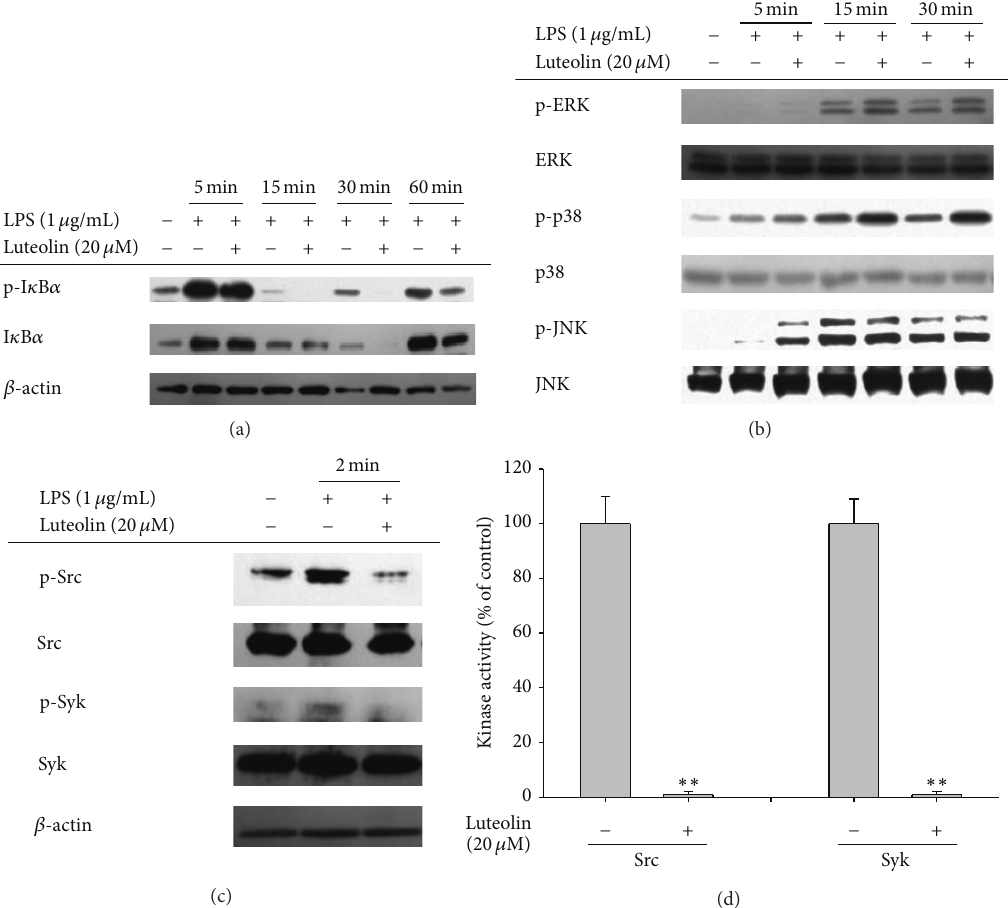
Figure 3: The effects of luteolin on the pathway upstream of NF- 𝜅 B activation. ((a), (b), and (c)) RAW264.7 cells (5 × 10 6 cells/mL) were incubated with LPS (1 𝜇 g/mL) in the presence or absence of luteolin for the indicated times. After preparing whole lysates, the levels of total or phosphorylated I 𝜅 B 𝛼 , Src, Syk, ERK, p38, and JNK were determined by immunoblotting. (d) The inhibitory effects of luteolin on Src and Syk activity were determined using a conventional kinase assay with purified Src and Syk. All data are expressed as the mean ± SD of experiments. ∗ 𝑝 < 0.05 and ∗∗ 𝑝 < 0.01 compared to the control